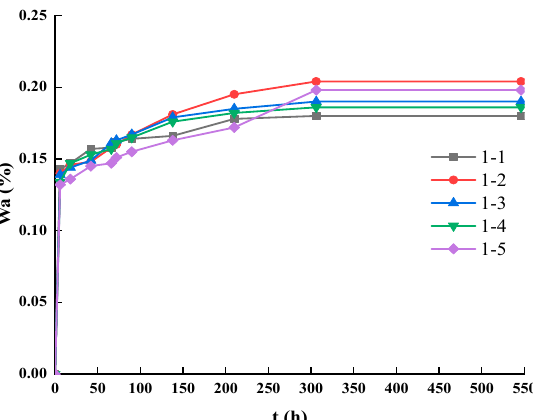
Figure 2. Diagram of sample water absorption changing with immersion time.